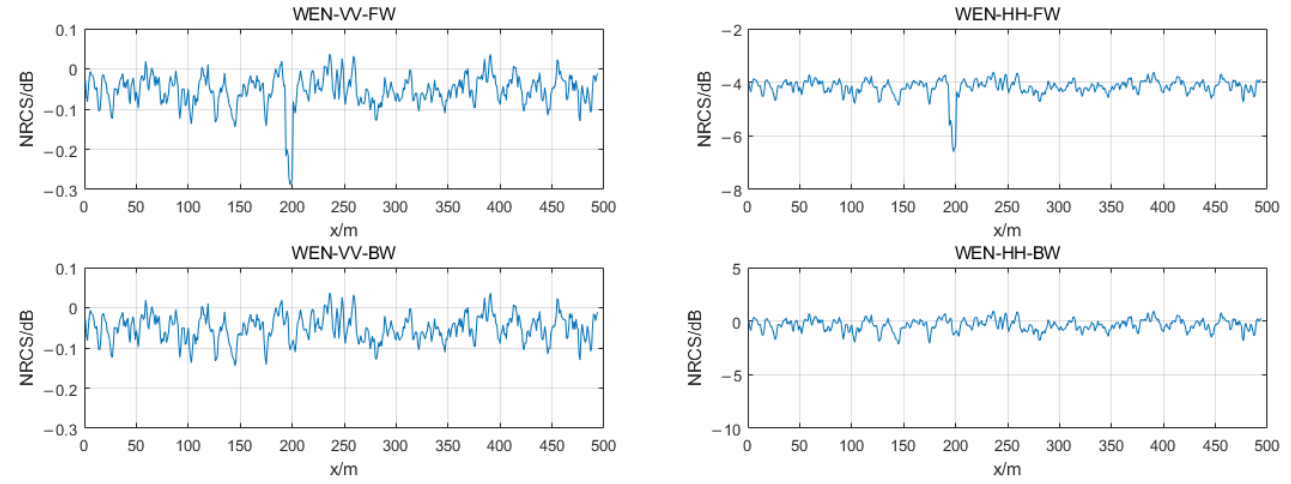
Figure 8. Comparison of NRCS results of freak wave (FW) and its background wave (BW) simulated by Wen’s spectrum under VV polarization and HH polarization.